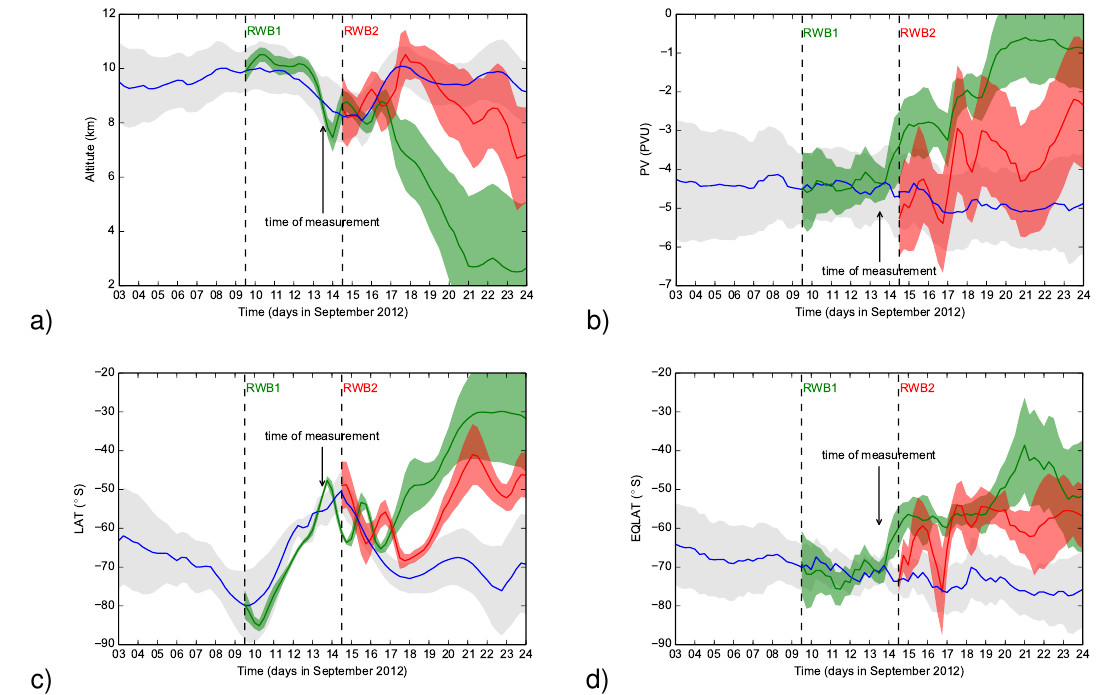
Figure 9. Air parcel properties based on trajectory analyses for all green-framed trajectories from Fig. 8 for the period of 2 weeks before to 2 weeks after the measurement. On 3 September the median of all 1400 trajectories is represented by the blue line with the respective standard deviation as gray shadow. At RWB event 1 a subset of 250 trajectories (green line, median) is separated from the rest (from that moment on the blue line represents 1150 trajectories). At RWB event 2 a subset of 200 trajectories (red line, median) is separated from the rest (from that moment on the blue line represents 950 trajectories): (a) median of potential temperature ( θ ), (b) median altitude above mean sea level, (c) median latitude, and (d) median equivalent latitude. The gray, green and red shaded areas marks the respective SD of the